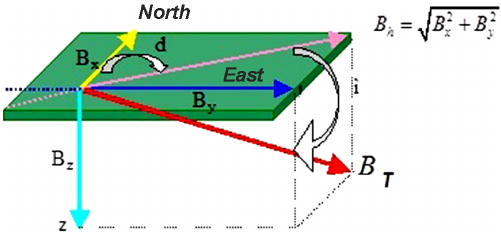
Figure 5. Example of the Earth’s magnetic field components, in- cluding the total magnetic field vector, which is measured by the equipment (source: S. Guimarães, author private collection, March